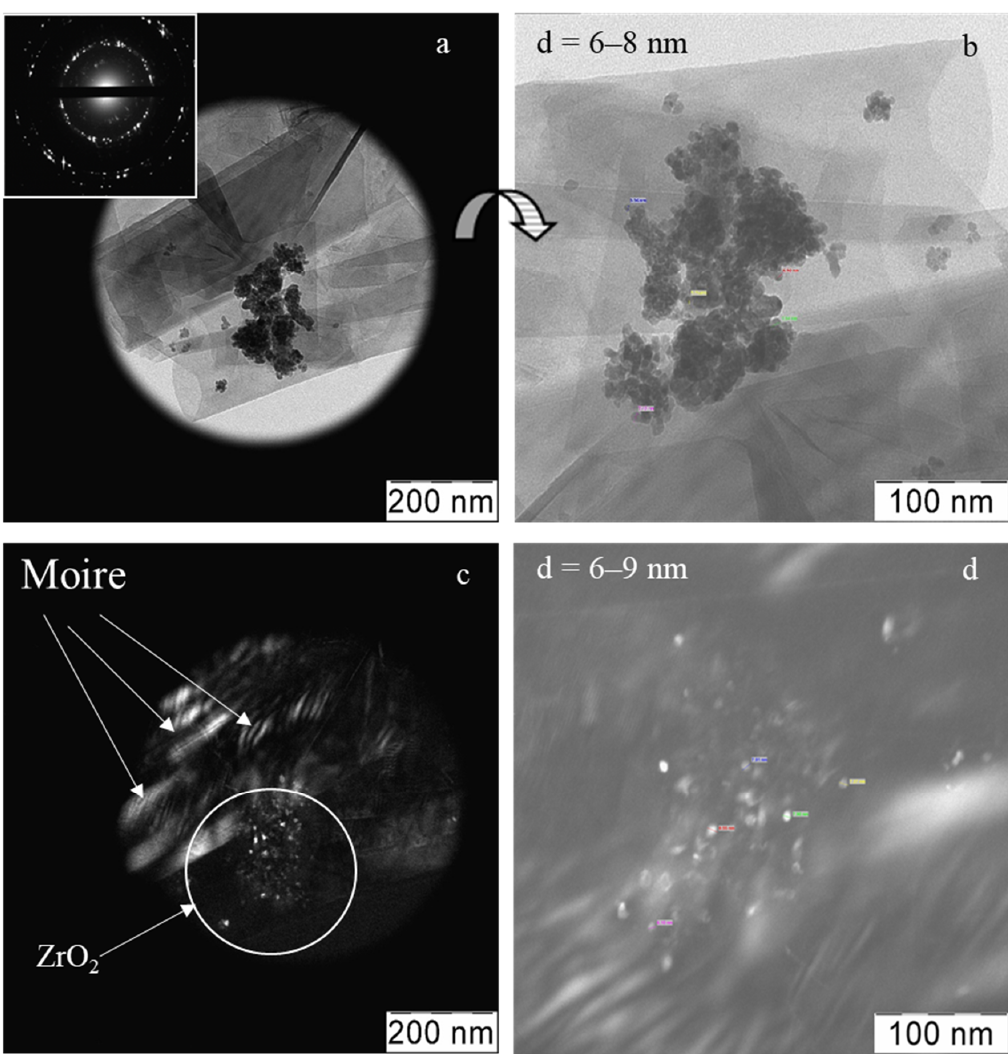
Figure 8. TEM images for the graphene-zirconia composite synthesized from the nano-zirconia and the graphene suspensions in isopropanol: light-field image and electron diffraction (inset) ( a ), enlarged and rotated by the 180° light-field image of the same area ( b ), dark-field image of the ZrO 2 agglomerate (marked by circle) between graphene sheets (moiré) ( c ), enlarged fragment with the automatically measured crystallites sizes ( d ).